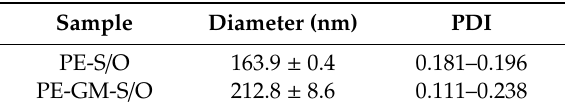
Table 1. Size analysis of S / O nanoparticles loaded with pollen extract (PE) or pollen extract- galactomannan conjugate